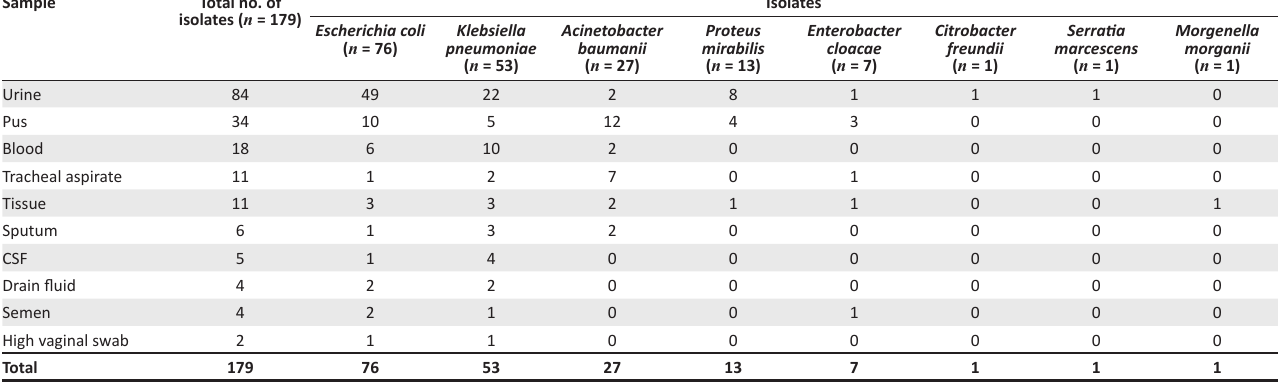
TABLE 1: Prevalence of individual pathogens in various samples at a hospital in Delhi, India, February 2017 to June 2017. Sample